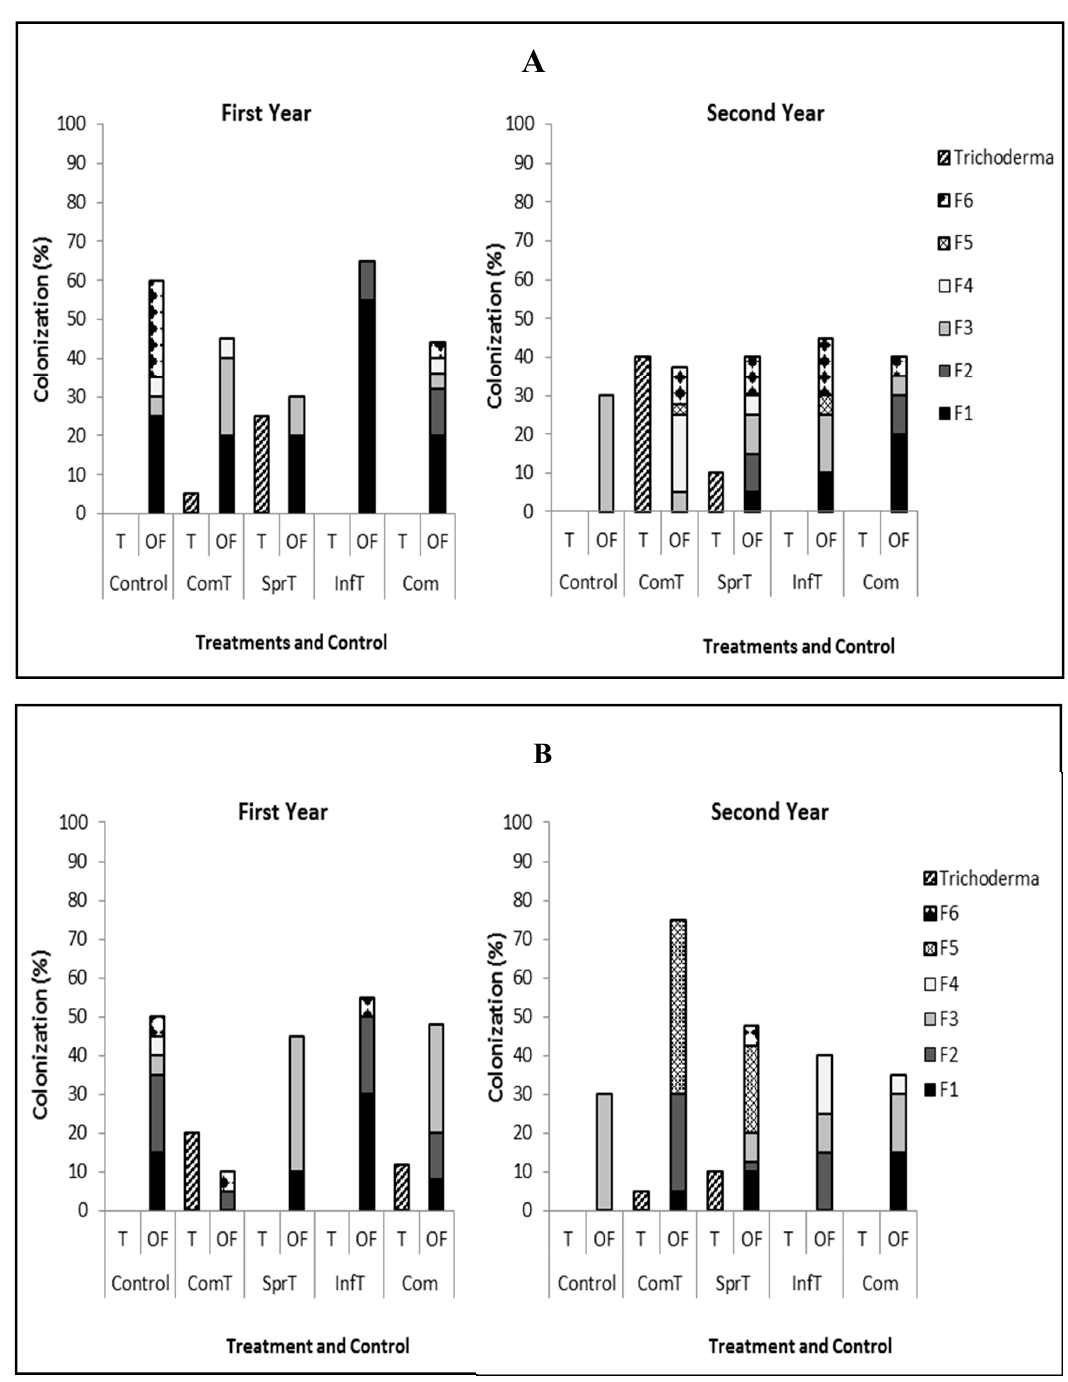
Figure 3. Colonization of Trichoderma asperellum and co-occurrence of endophytic fungi in branch tissues ( A ) and root tissues ( B ) in the first and second year. T = Trichoderma, OF = other fungi, ComT = compost plus Trichoderma , SprT = spraying of Trichoderma , InfT = infusion of Trichoderma , Com = compost, F1–F5 = Lasiodiplodia morphospecies 1–5, F6 = Fusarium .